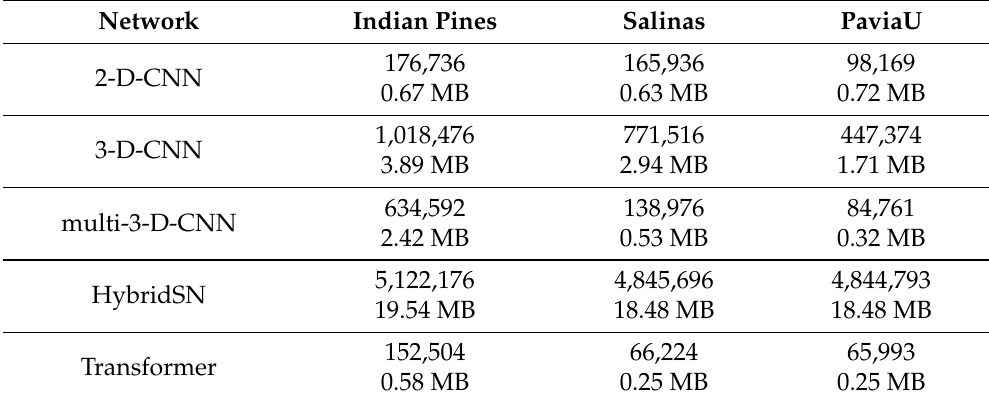
Table 11. Parameter size of the five methods on the three hyperspectral data sets.